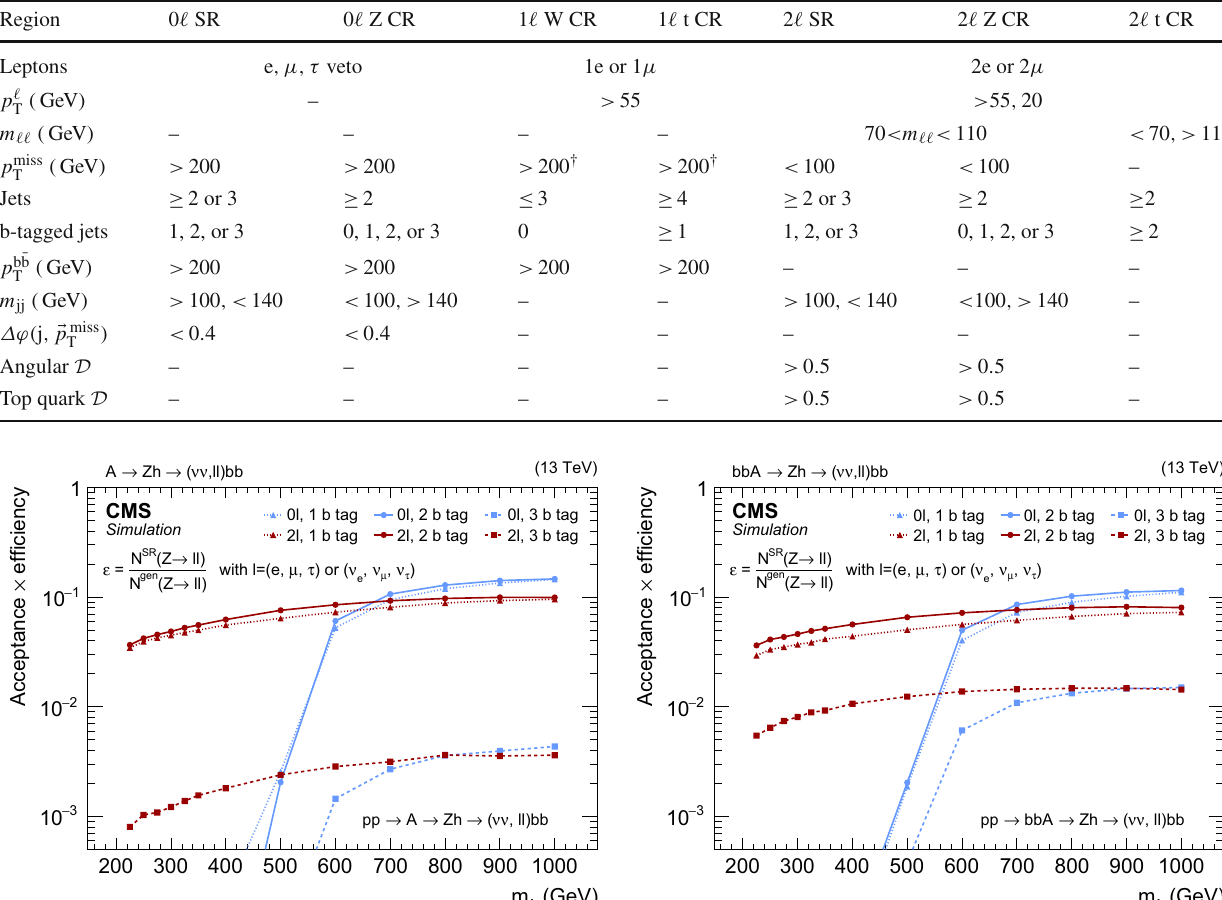
Table 1 Definition of the signal and control regions. In 2 (cid:5) regions, the leptons are required to have opposite electric charge. The entries marked with † indicate that the p miss T